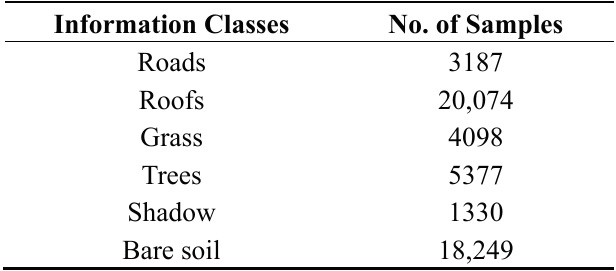
Table 2. The numbers of samples in the reference data for the GeoEye-1 Wuhan image.